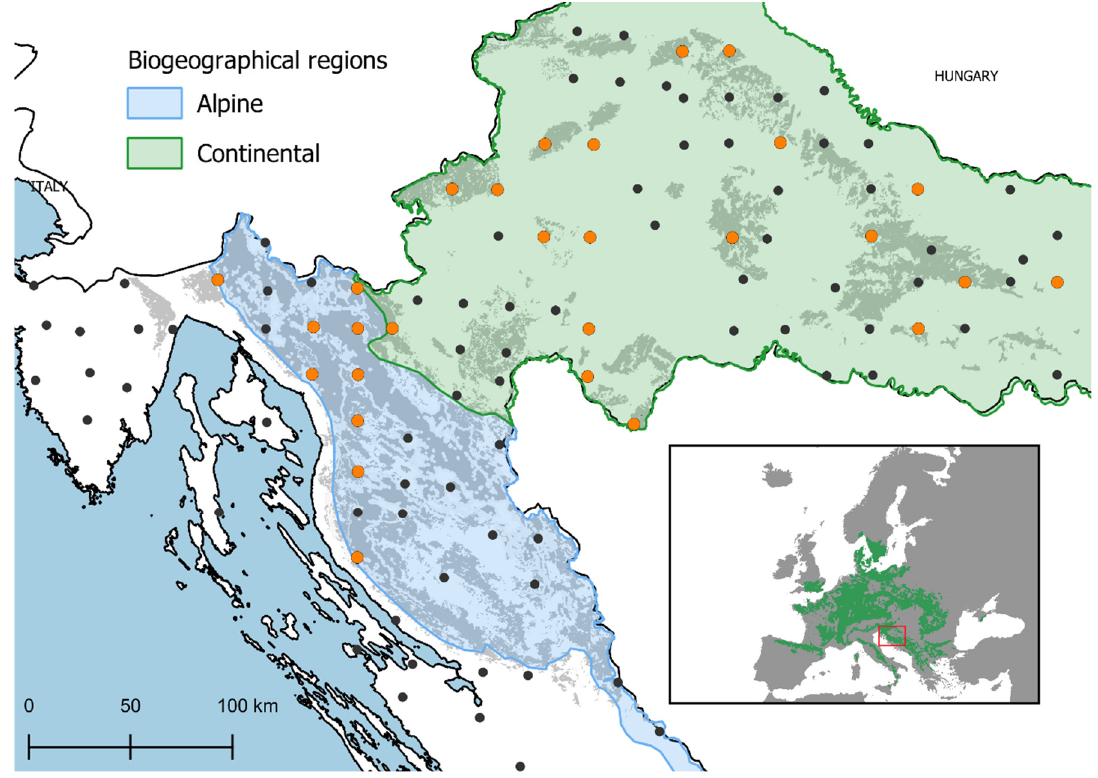
Figure 3. Location of research plots and distribution of European beech in Europe [65]. Selected Level I ICP Forests monitoring plots (orange dots); remaining Level I plots in Croatia (black dots); distribution of European beech forests in Croatia [66] (gray polygon); biogeographic region in the study area (shaded polygon) [67].